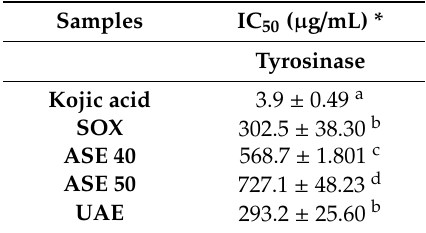
Table 4. Results of inhibitory activity against tyrosinase